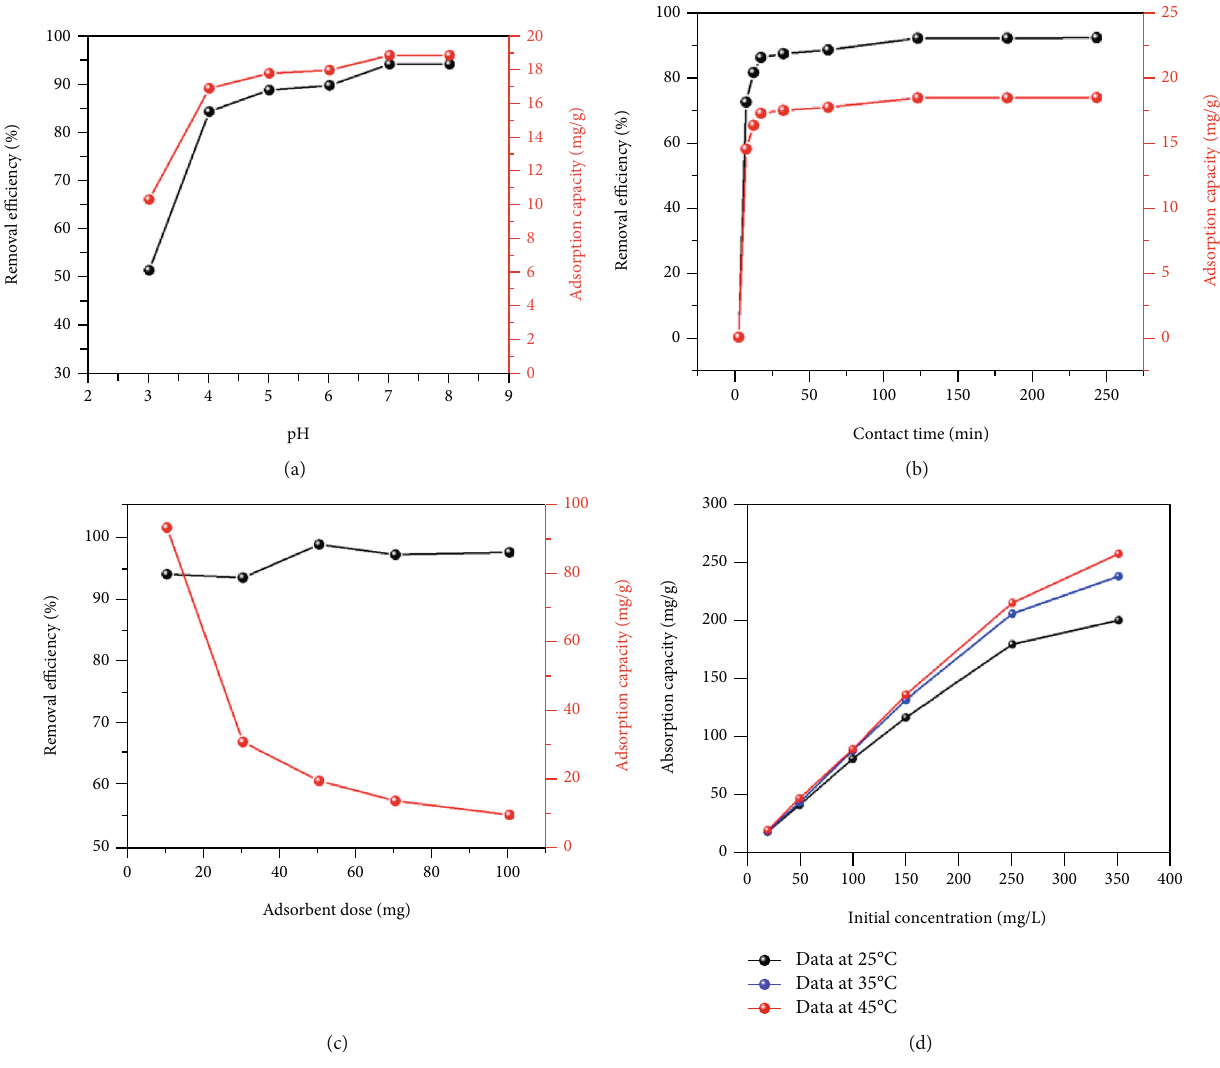
Figure 5: (a) E ff ect of pH value (conditions: MG — 20mg/L, time — 24h, Fe agitation — 100 rpm), (b) contact time (conditions: MG — 20 mg/L, pH — 7, Fe temperature — 25 ° C), (c) adsorbent dose (conditions: MG — 20mg/L, pH — 7, time — 120 min, temperature — 25 ° C, and agitation — 100 rpm), and (d) initial MG concentration (conditions: time — 120, Fe on the adsorption of MG on Fe